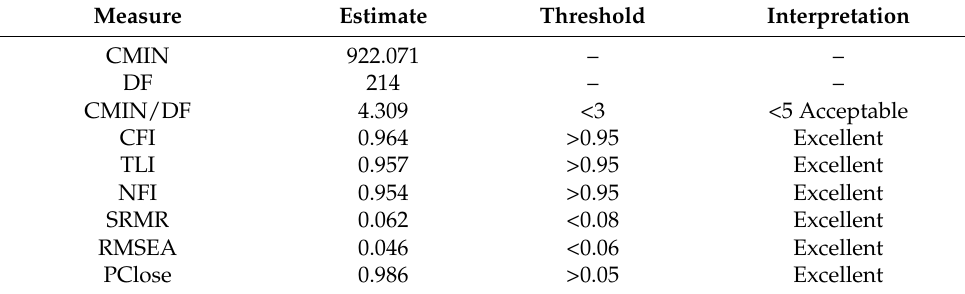
Table 2. Confirmatory factor analysis